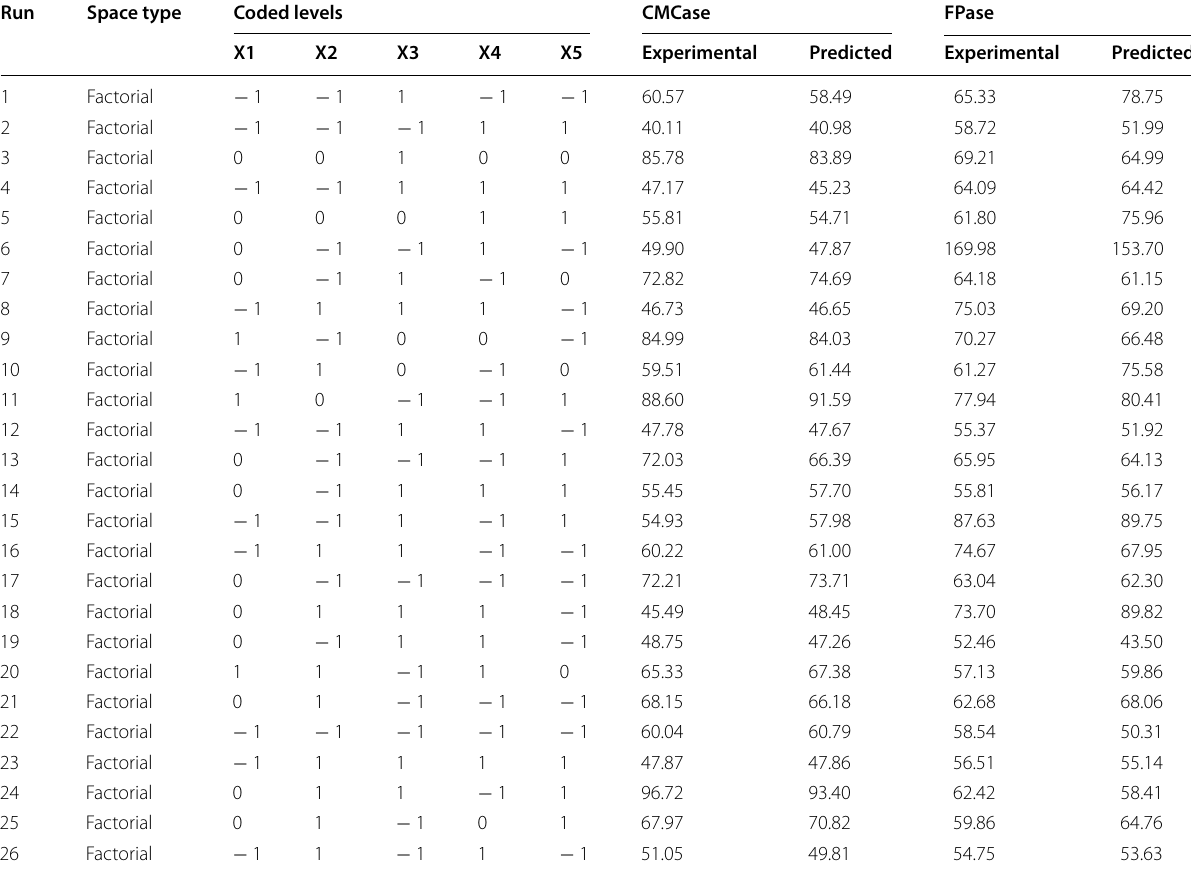
Table 2 Experimental design with coded levels of variables used in CCD-RSM with predicted and experimental CMCase and FPase activity for Schizophyllum commune NAIMCC-F-03379